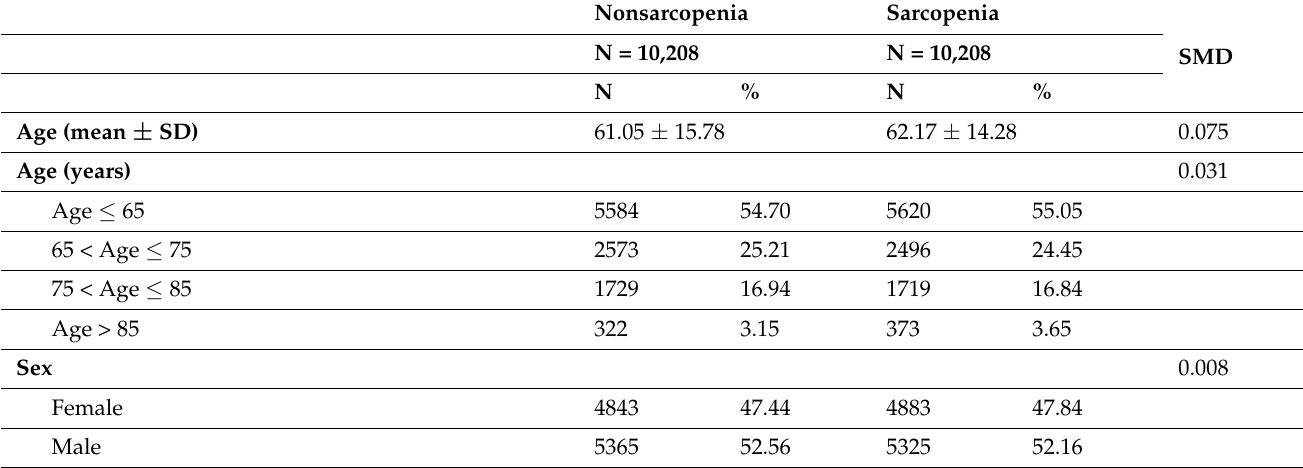
Table 1. Characteristics of patients with cancer in the sarcopenia and nonsarcopenia groups receiving cancer treatments (after propensity score